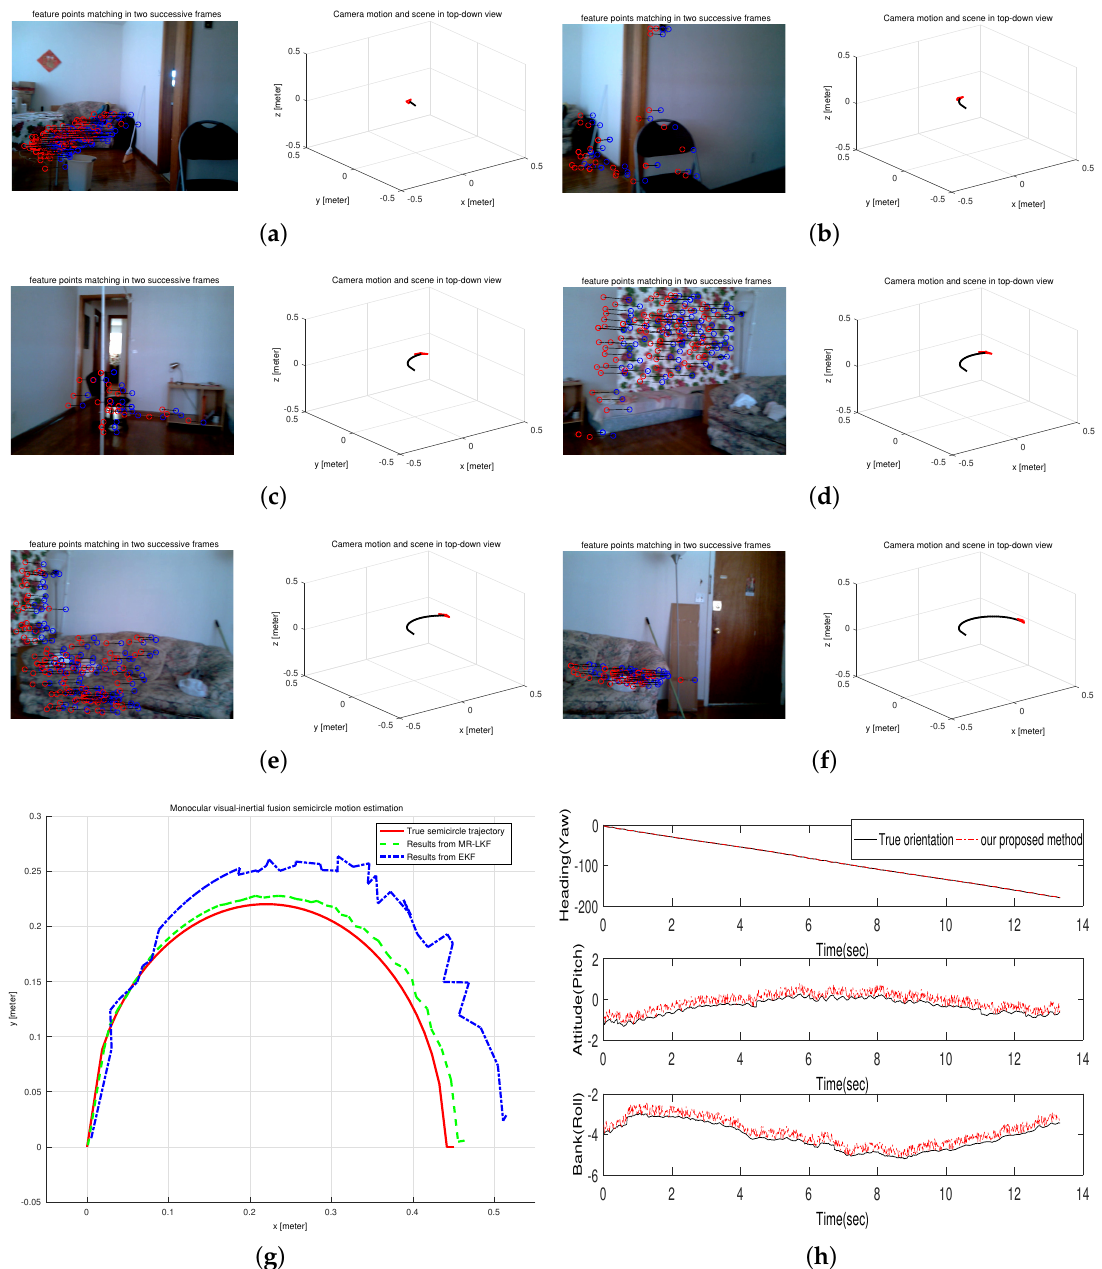
Figure 12. Semicircle Motion Estimation in a home-based environment. ( a – f ) typical frames; ( g ) estimated trajectory; ( h ) Orientation